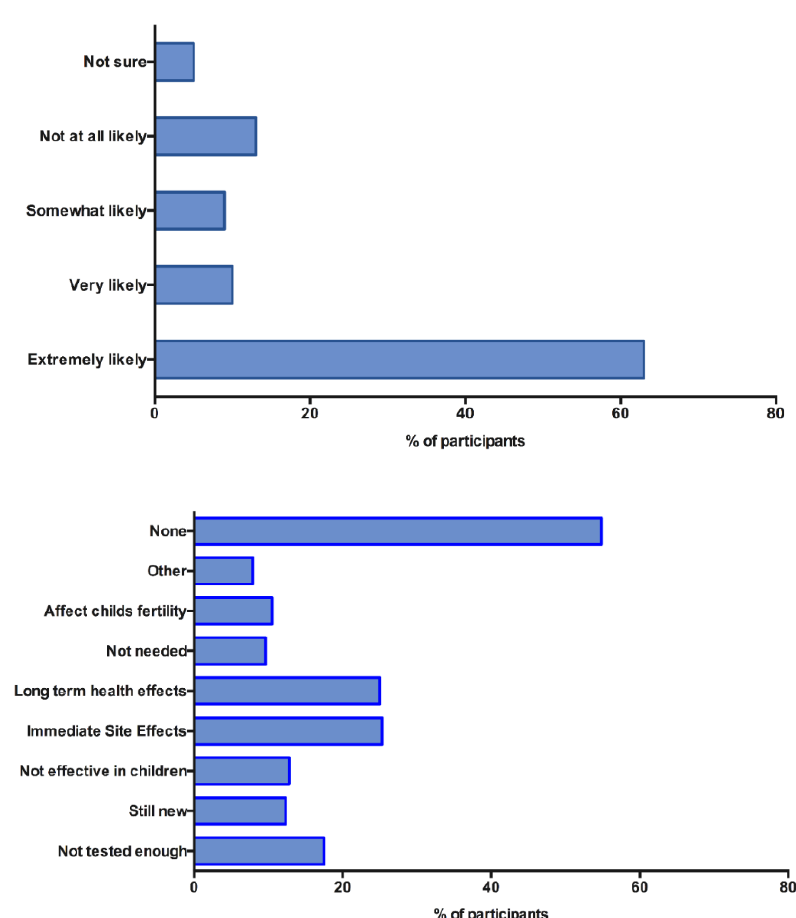
Figure 2. Attitudes towards COVID-19 vaccines for children. ( a ) Likelihood of vaccinating children. Participants were asked “If the COVID-19 vaccine was available to your child, how likely would you be to get your child vaccinated” ( b ) Concerns about vaccines for children, participants were asked “What concerns about COVID-19 vaccines for do you have, if